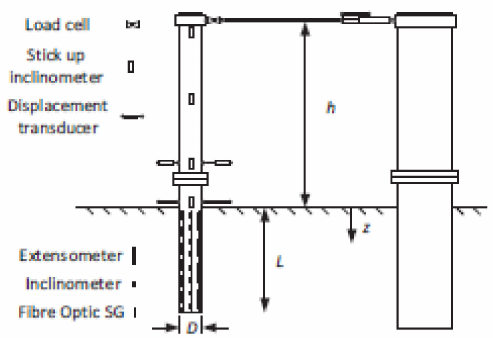
Figure 8. Diagram of PISA